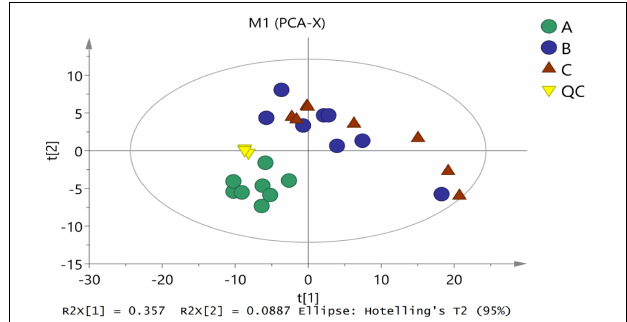
FIGURE 2 | The score plots of PCA for metabolite profiles in P. tuoliensis mycelia. A, Mycelia A samples; B, Mycelia B samples; C, Mycelia C samples; QC, quality control sample.